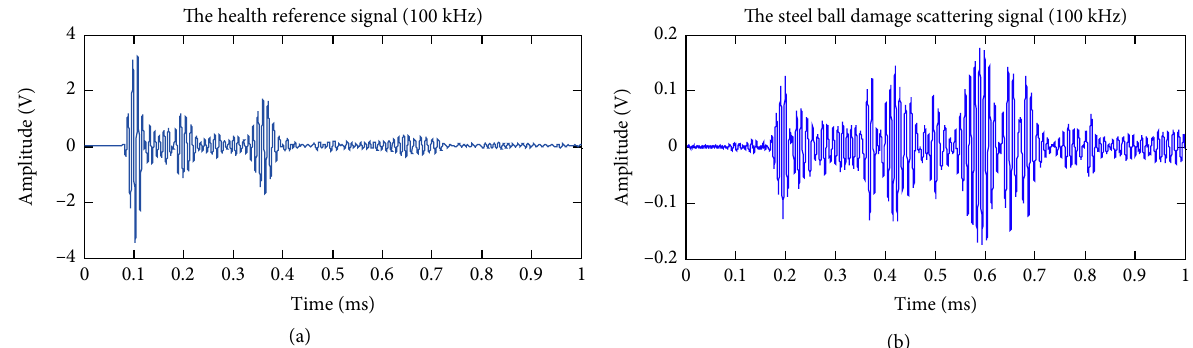
Figure 6: The monitoring signals with a central frequency of 100 kHz in different condition. (a) The health reference signal; (b) the steel ball damage scattering